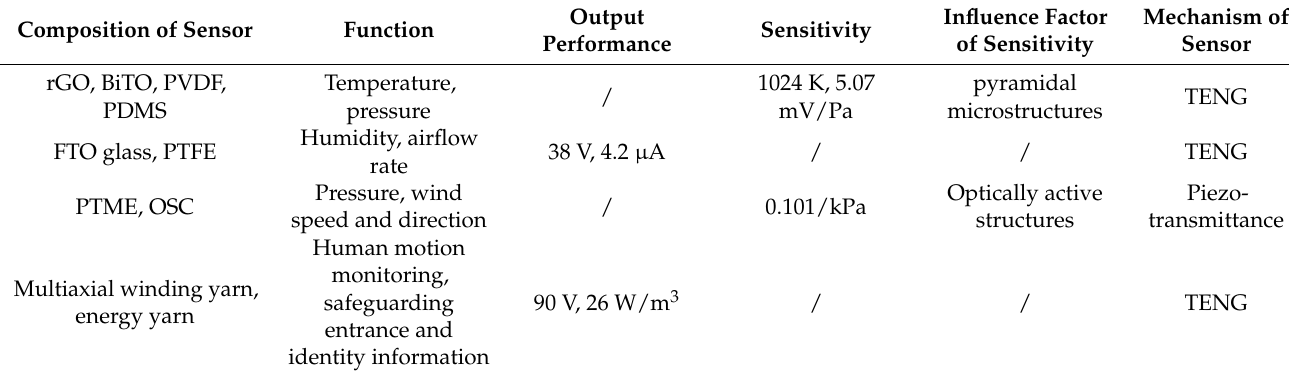
Table 3. Comparisons of self-powered multifunctional flexible